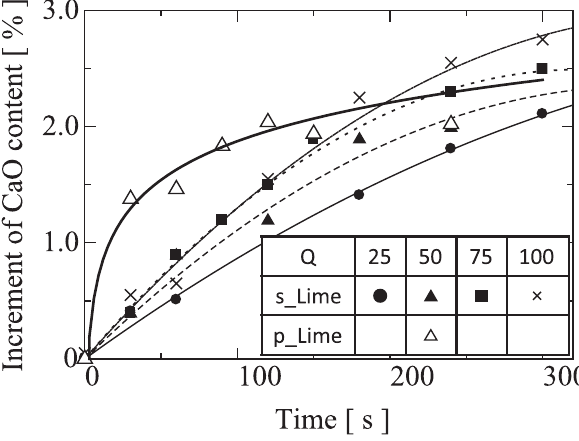
Fig. 10: Increment of CaO content when 3.5 g of sintered lime (s-Lime) dissolved into 100 of FeO-CaO-A